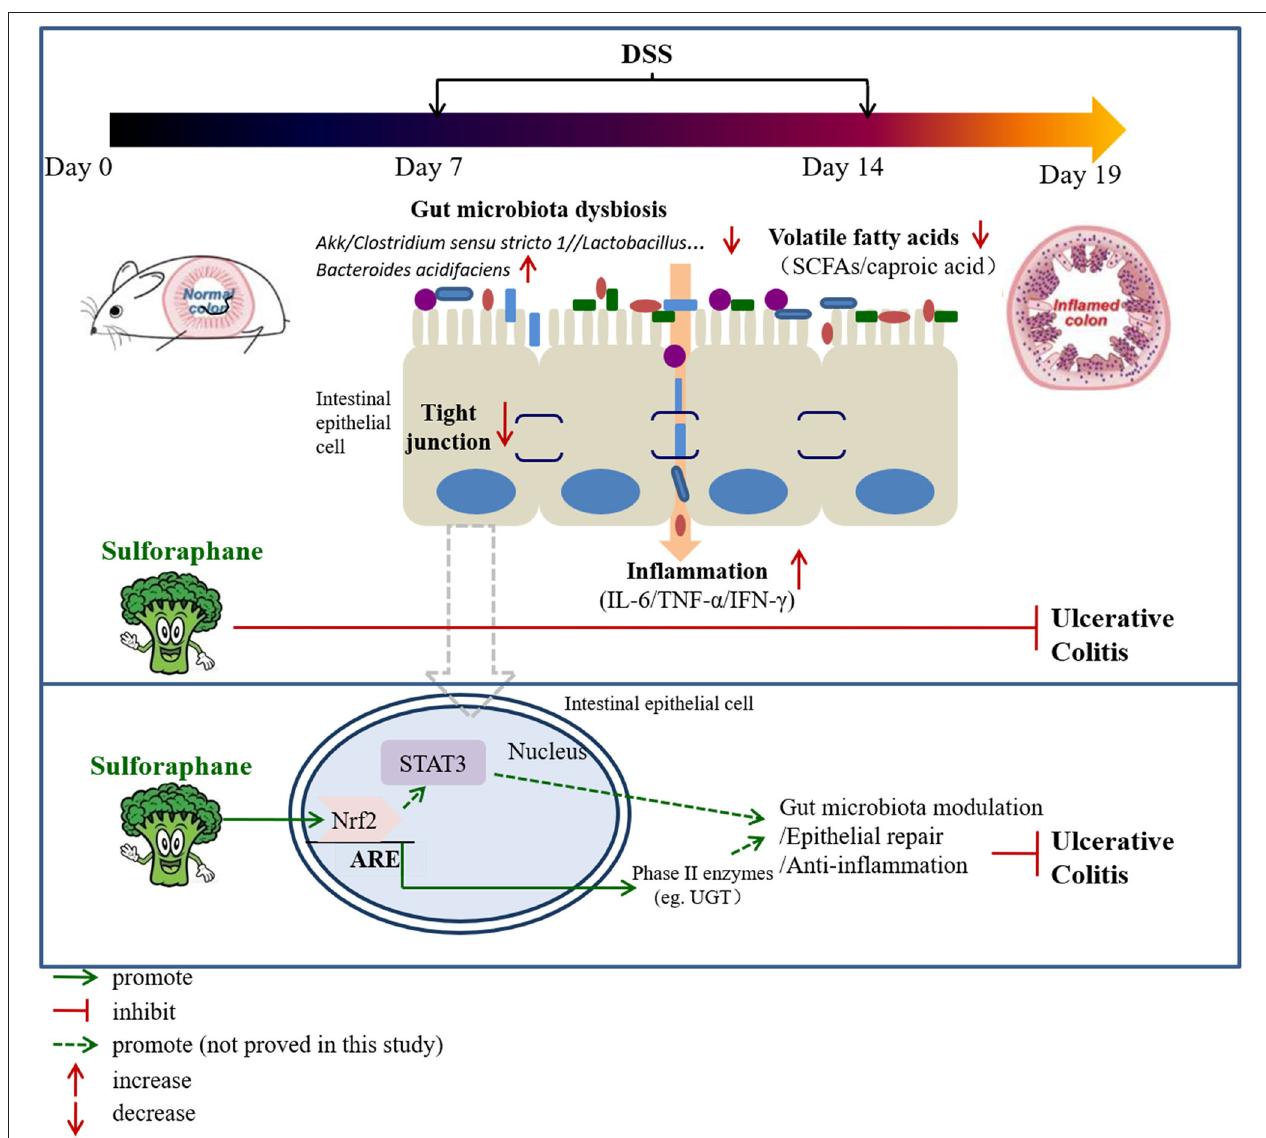
FIGURE 9 | A proposed mechanism by which SFN protects against